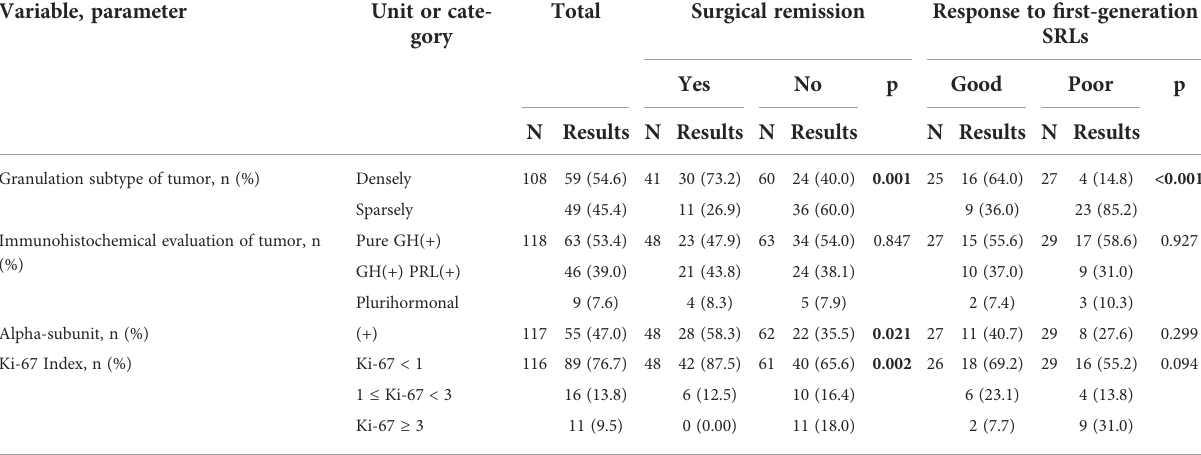
TABLE 3 Pathomorphological presentation of the study cohort. Variable,